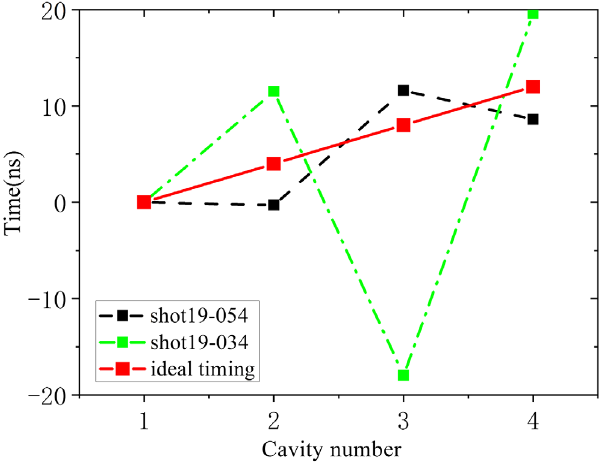
FIG. 12. Relative drive timing of the four-cavity IVA for shot 054 (black trace) and shot 034 (green trace). The ideal timing (red traces) is also